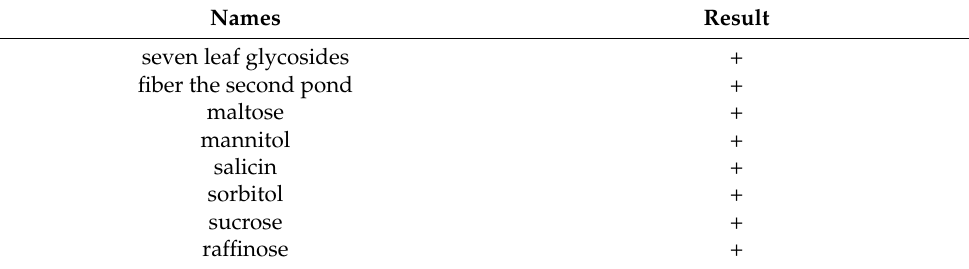
Table 1. Biochemical identification table of Lactiplantibacillus plantarum MMB-05.